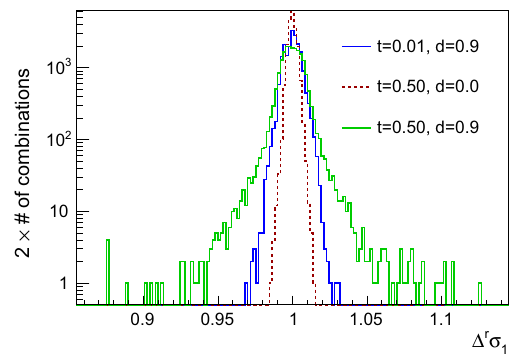
Fig. 8 Ratio of the uncertainties on ¯ x 1 obtained with the method pro- posed in this document and using a direct likelihood combination. The distribution is shown for different values of the scale for systematic uncertainties t and the statistical correlation between the estimates d . The combination assumes no correlation between the uncertainties of both pseudo-measurements